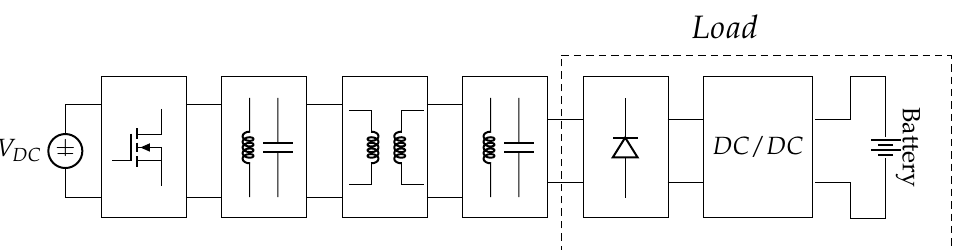
Figure 1. DC/DC power conversion stage for a WPT battery charger system, starting from the rectified voltage up to the